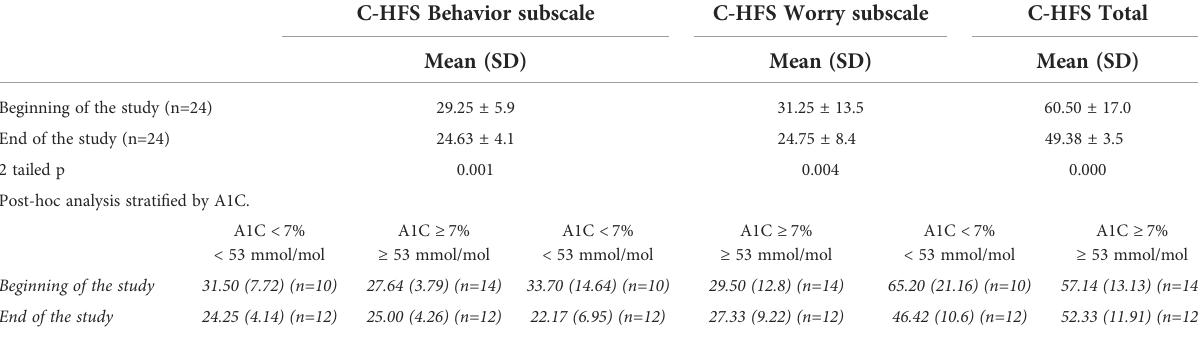
TABLE 3 Comparison of average Behavior and Worry, C-HFS total score with a post - hoc analysis for participants with A1C < 7% (< 53 mmol/ mol) versus A1C ≥ 7% ( ≥ 53